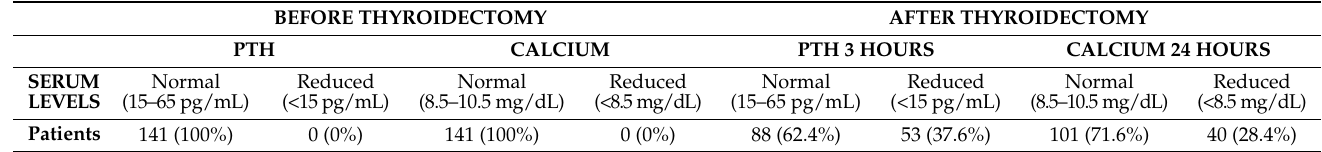
Table 2. Serum levels of PTH and the calcium after thyroidectomy.